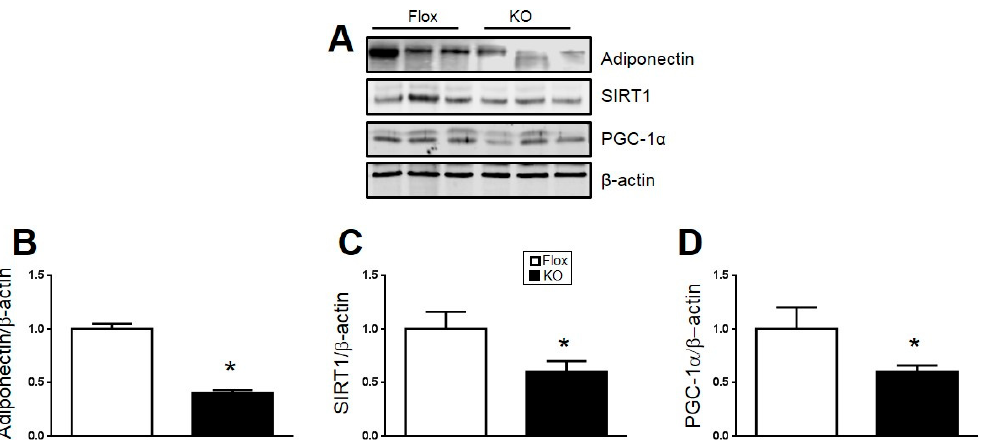
Figure 7. ( A ) Representative Western blots from adipose of male mice after 30 weeks of high-fat diet; ( B ) protein levels of Adiponectin; ( C ) protein levels of Sirtuin-1 (SIRT1); and ( D ) protein levels of peroxisome proliferator-activated receptor gamma coactivator 1- α (PGC-1 α ). * p < 0.05 compared to the corresponding value in Flox mice. n = 6/group.